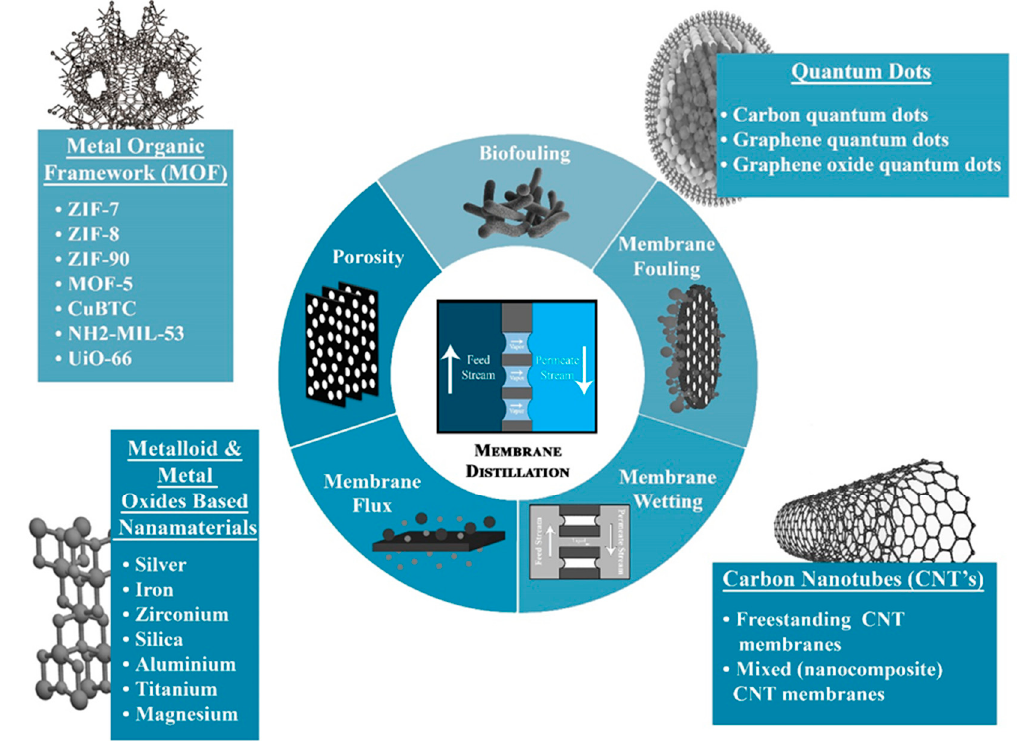
Figure 6. Recent advancements towards the application of MD in seawater desalination by utilizing various classes of new generation nanomaterials.